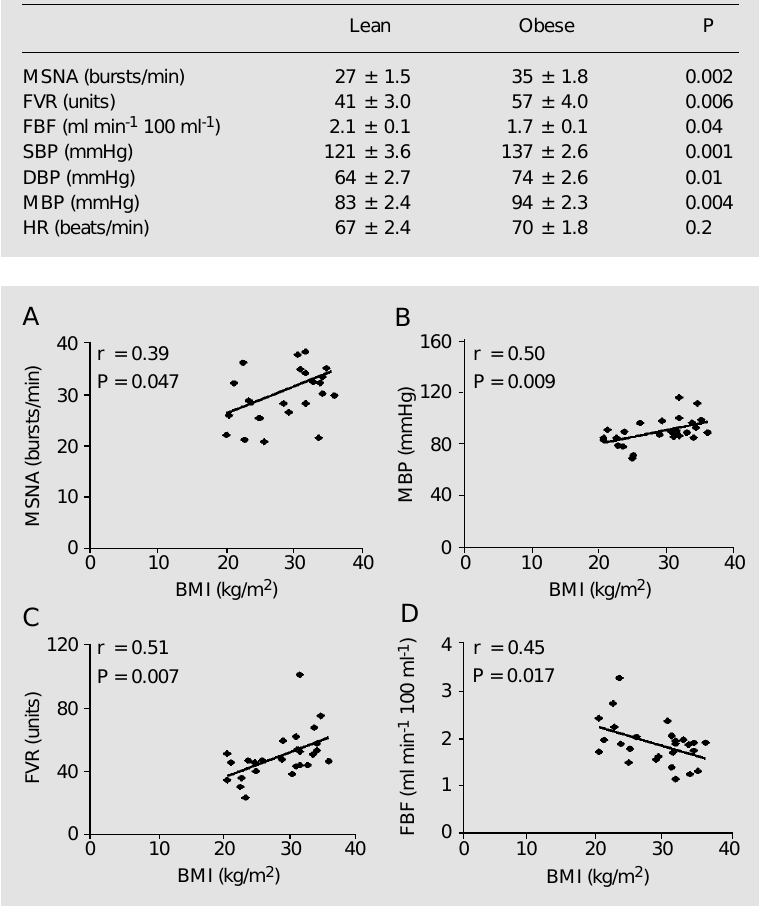
Table 1 - Baseline measurements of muscle sympathetic nerve activity (MSNA), forearm vascular resistance (FVR), forearm blood flow (FBF), systolic (SBP), diastolic (DBP) and mean blood pressures (MBP), and heart rate (HR) in obese and lean women.